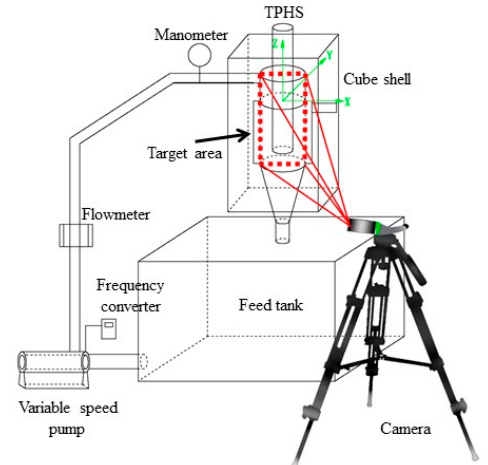
Figure 2. Schematic diagram of experimental rig.